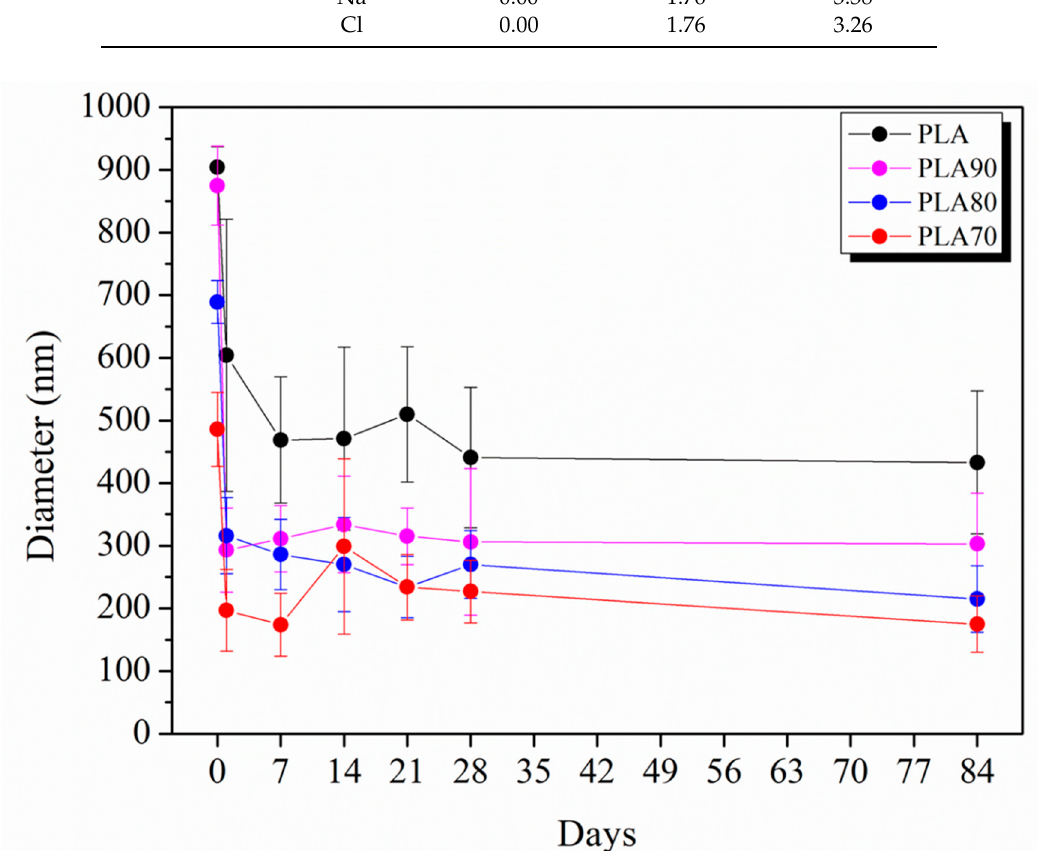
Figure 2. Diameter evolution measured by SEM of neat PLA and each PLA:OLA electrospun samples by increasing the days of degradation in PBS.